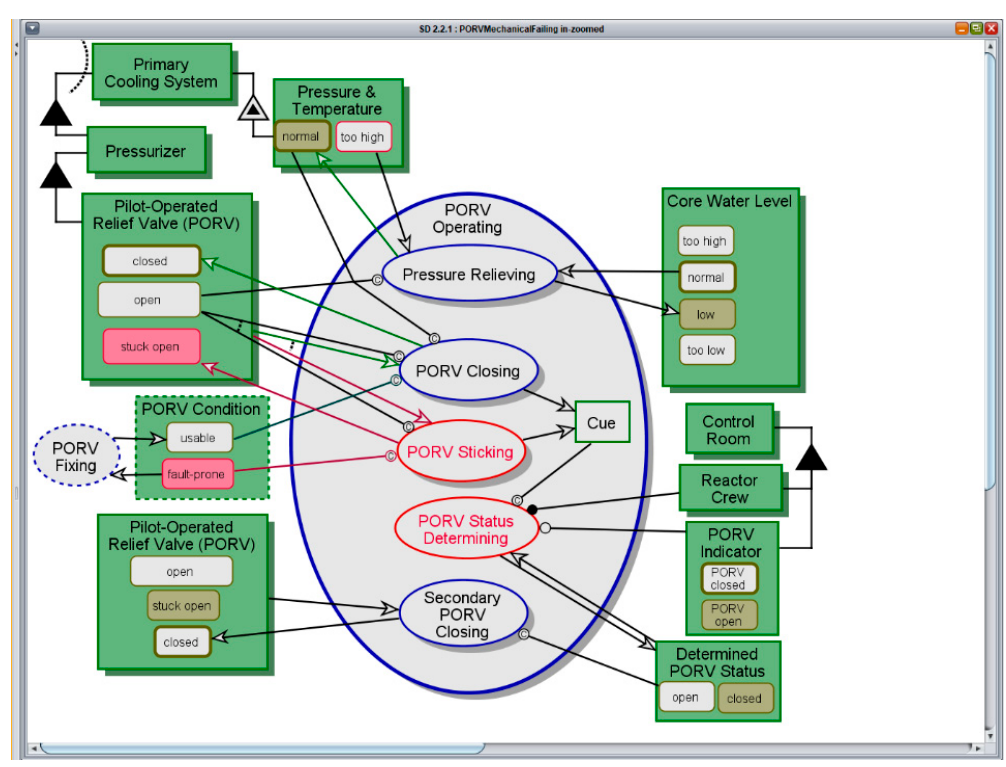
Figure 10. PORV Operating—CPG-Aware Model.